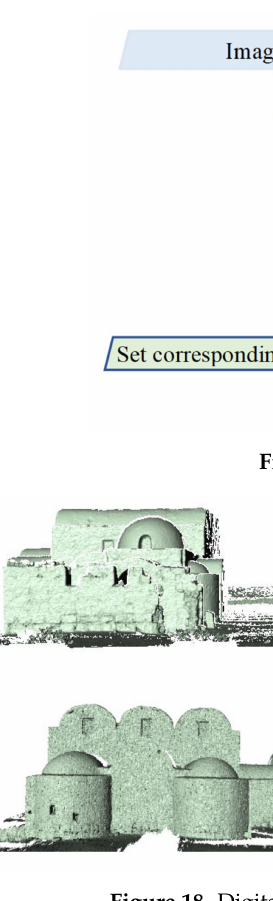
Figure 18. Digital Surface Model (DSM) and gridded DSM (depth images).